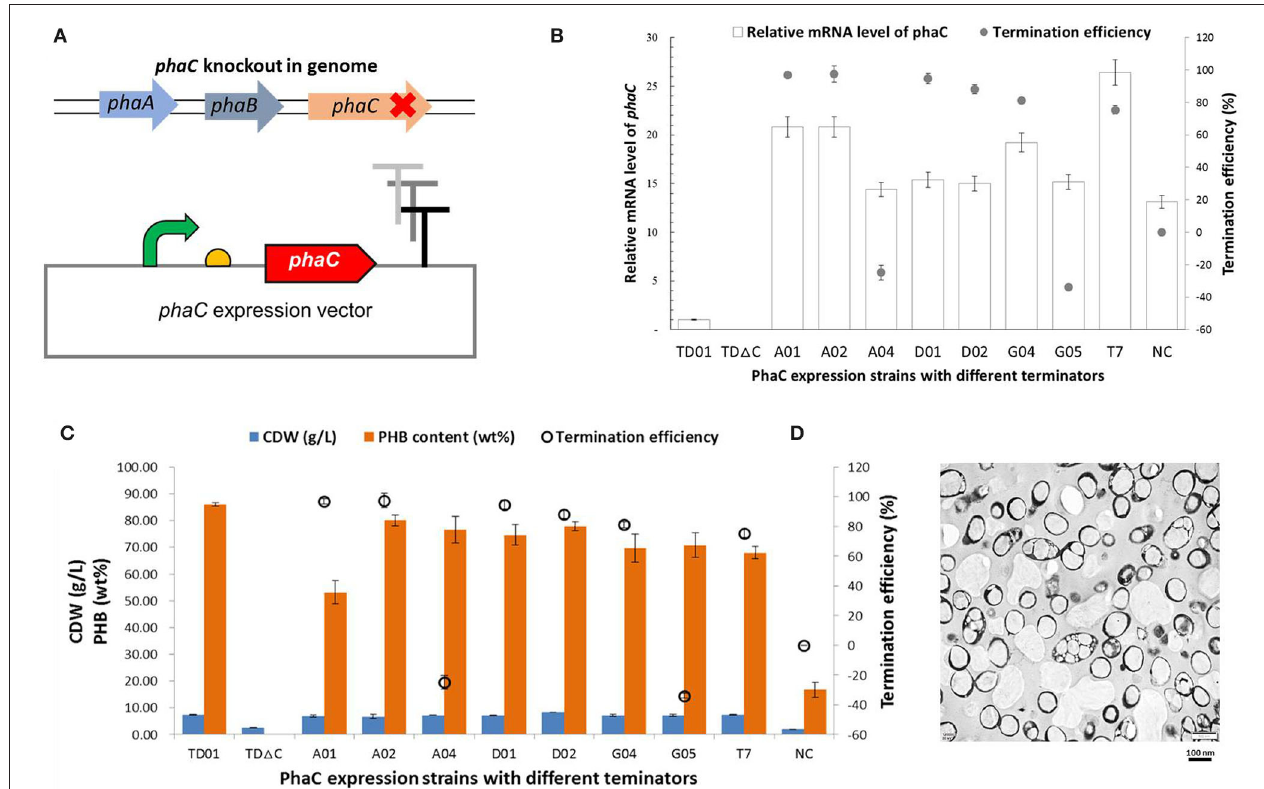
FIGURE 6 | PHB production regulated by terminators with different efficiencies. (A) The phaC expression vectors were constructed with a series of native or engineered terminators, to rescue the deletion of phaC gene in H. bluephagenesis TD01 genome. (B) The relationship of the relative intracellular mRNA level of phaC gene and the termination efficiency. (C) Cell dry weight and PHB content in the recombinant H. bluephagenesis TD strains harboring different phaC expression vectors. (D) TEM observations of PHA granules in the recombinant H. bluephagenesis TD strains with PHB production regulated by the terminator